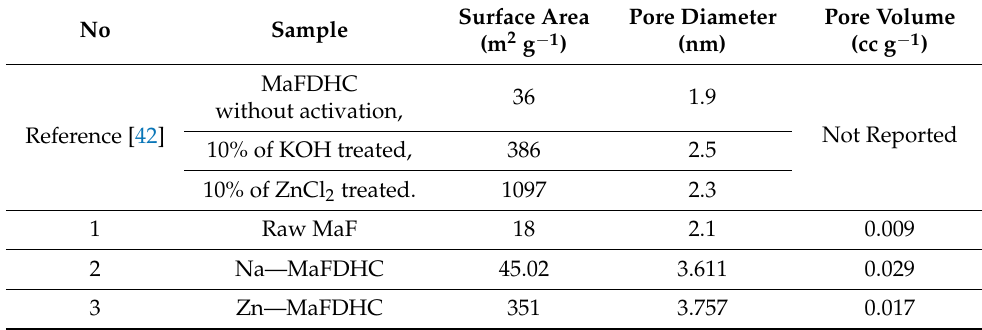
Table 1. Textural properties of MaFDHC samples compared with reported